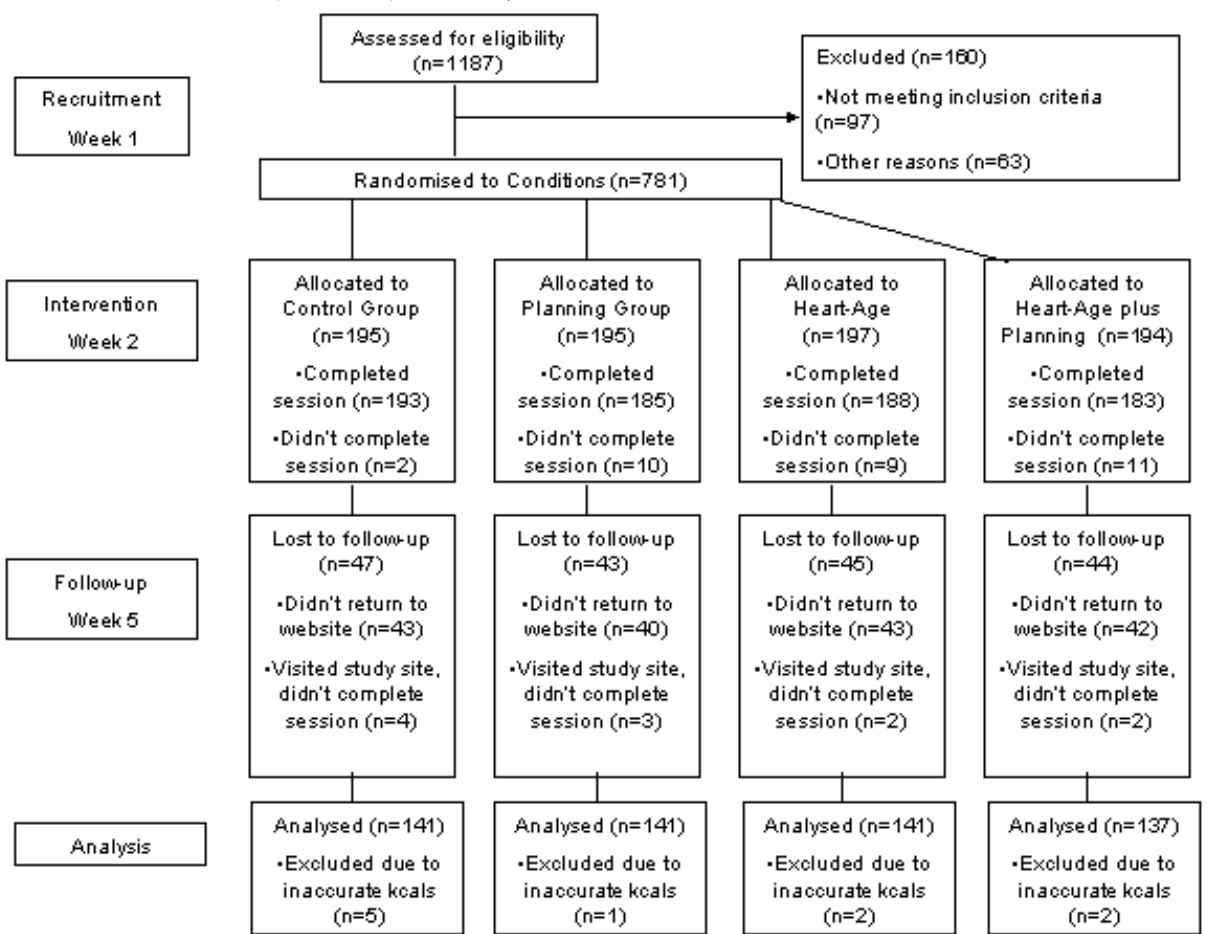
Figure 3. Flow chart of recruitment, intervention, and